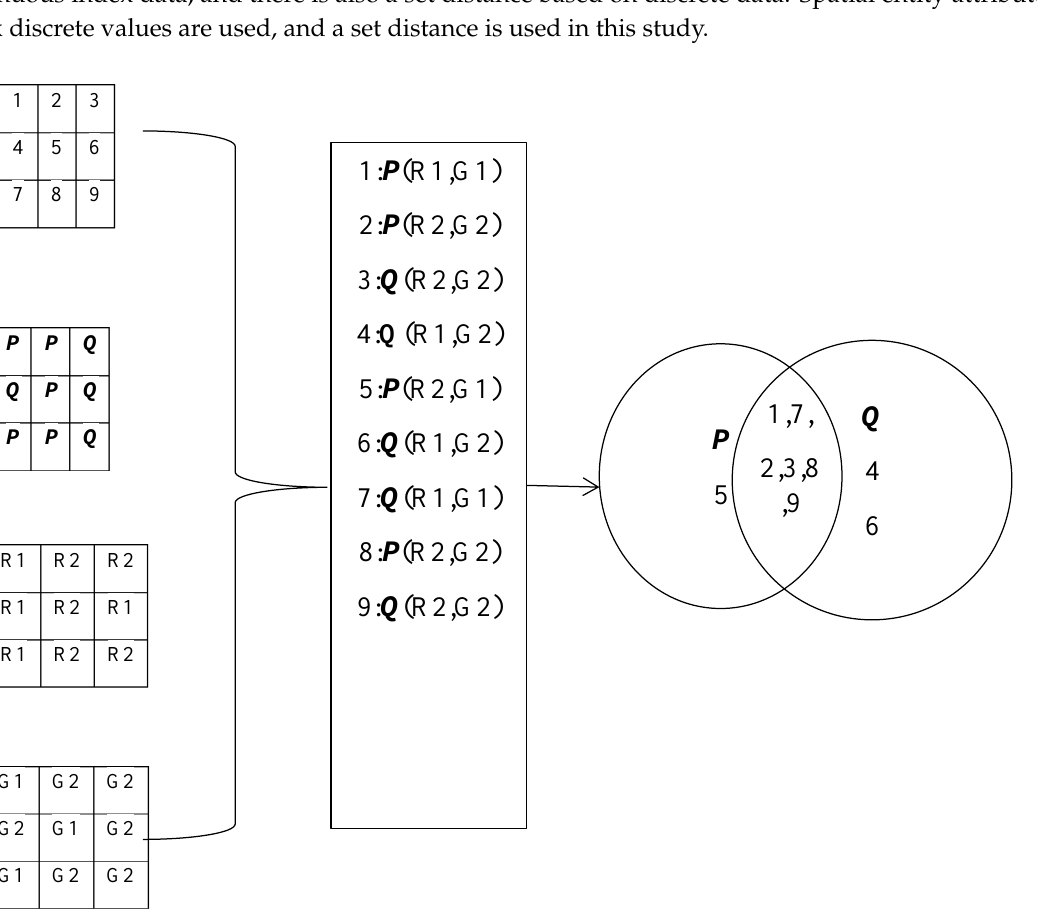
Figure 1. Spatial entity set distance solution process diagram.